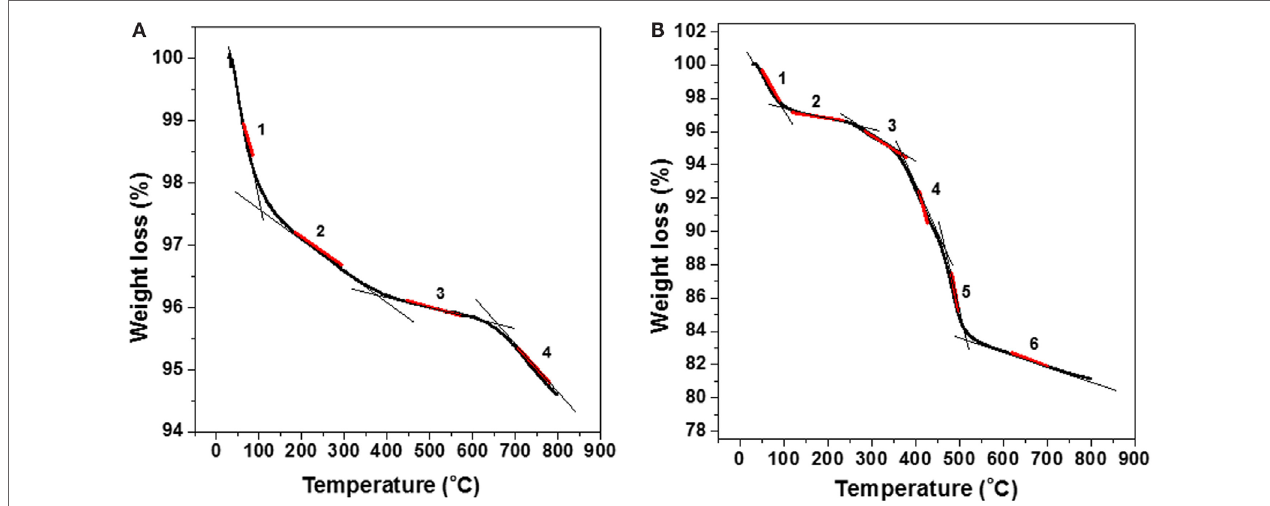
FigUre 1 | Thermogravimetric curve (Tga) for halloysite without dodecylamine corrosion inhibitor (a) and loaded with dodecylamine corrosion inhibitor (B) .